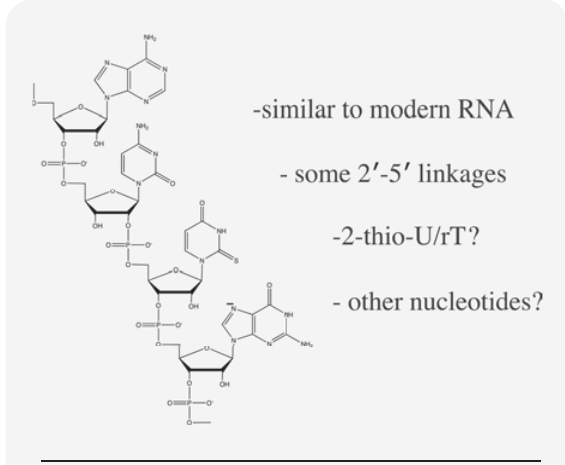
structure is RNA, but it contains some 2 ′ -5 ′ linkages as well as some non-standard nucleobases such as